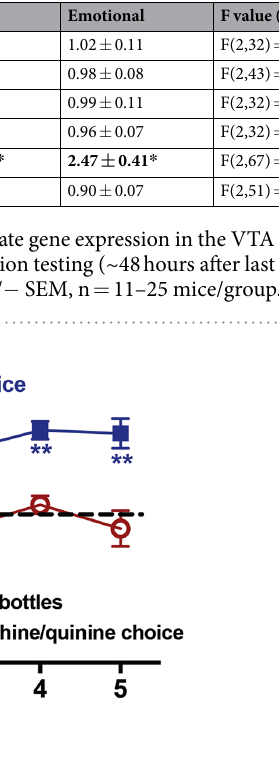
Figure 4. Establishment of voluntary morphine consumption. All mice had access to two bottles containing 0.2% sucrose in their home cage (day 1–2, open circles), and then either continued to have access only to 0.2% sucrose (red open circles) or a choice of 0.3 mg/ml morphine sulfate and 0.06 mg/ml quinine sulfate in 0.2% sucrose (blue squares) on days 3–5. Mice given a choice preferred the morphine solution to the quinine bitter taste control, n = 8